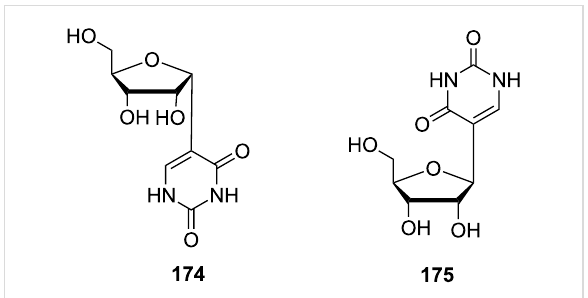
Figure 10: α - and β -pseudouridine ( 174 and 175 ).